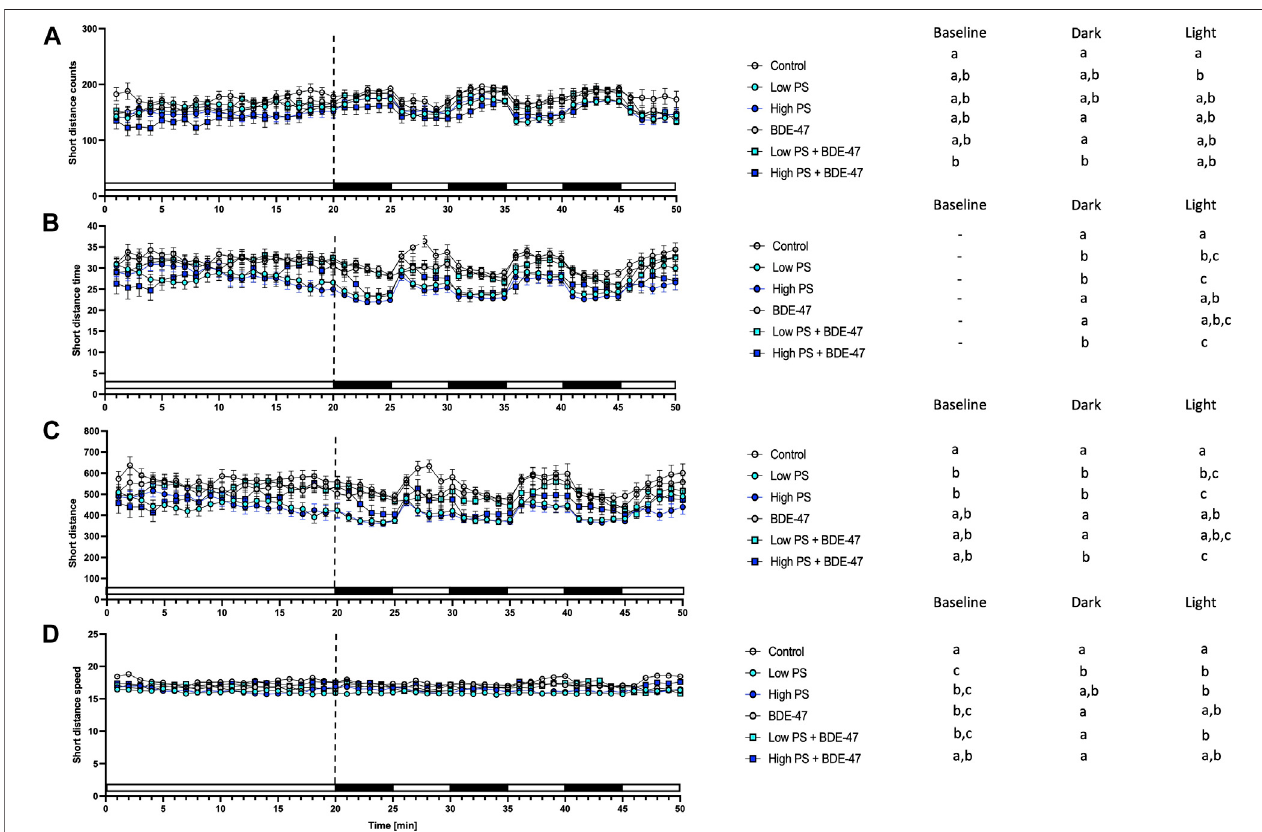
FIGURE7| Shortmovementparametersfrom7 dpfzebra fi shlarvaelocomotionassays( n =3)withatotal n =48foreachtreatmentgroups.Allmeasurementsover the 50 min assays were binned in 1 min units, with 20 min baseline followed by 3 cycles of 5 min dark light alterations. Average short counts of movement events +/ − S.E.M. (A) , average duration of total movement events +/ − S.E.M in s (B) , Distance of short movement events +/ − S.E.M in mm (C) , Average speed +/ − S.E.M of short movements in mm/s (D) . Data were analyzed using separate one-way repeated measurement ANOVAs for baseline, dark, and light conditions. Signi fi cant treatment effects ( p < 0.05) are shown in Table 1 , and speci fi c post-hoc analysis results are depicted next to the graphs for all parameters. Different letters indicate signi fi cant differences between groups as analyzed by Tukey ’ s post-hoc test ( p < 0.05).